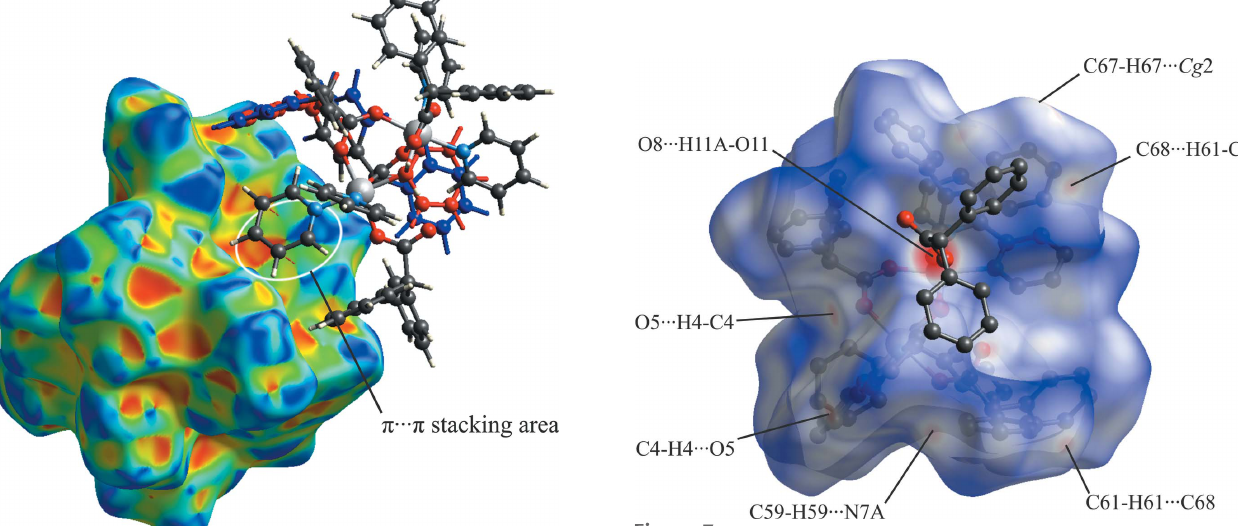
Figure 6 Hirshfeld surface of compound 1 plotted over shape-index.